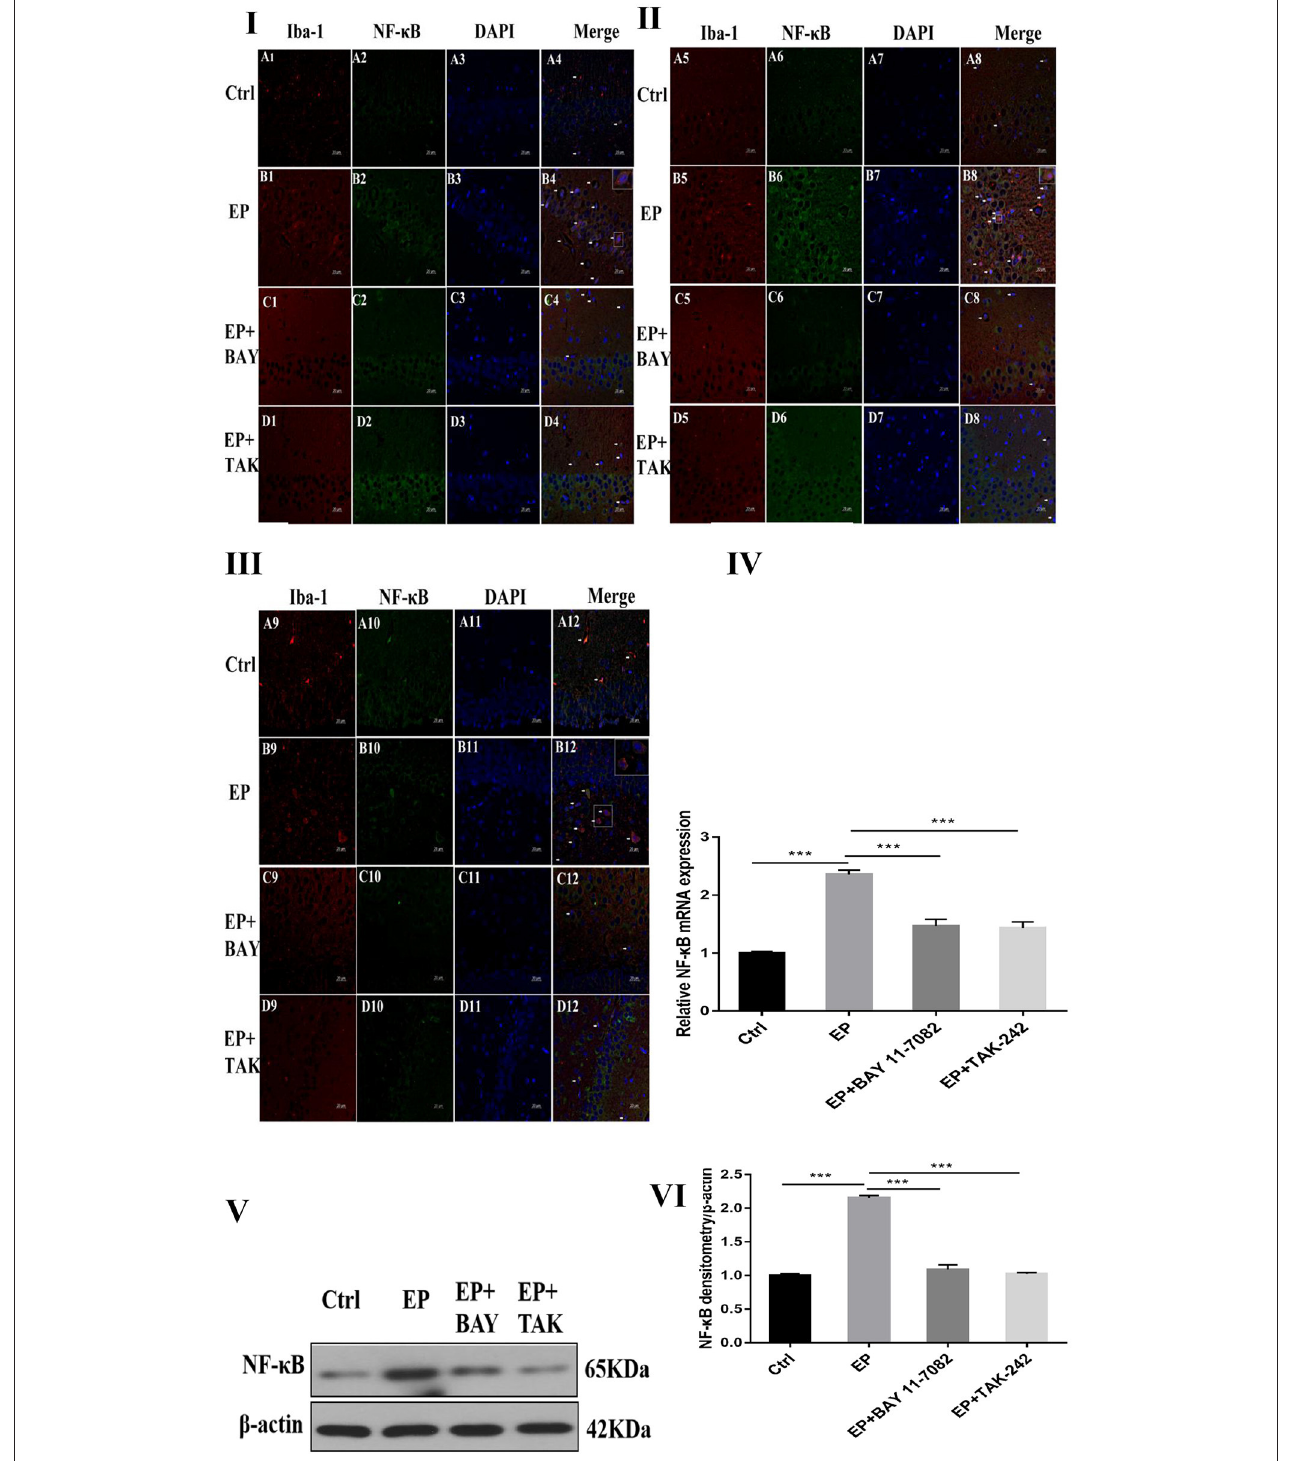
FIGURE 3 | NF- κ B expression after I downregulated the TLR4/NF- κ B inflammatory pathway. * P < 0.05; ** P < 0.01; *** P < 0.001.